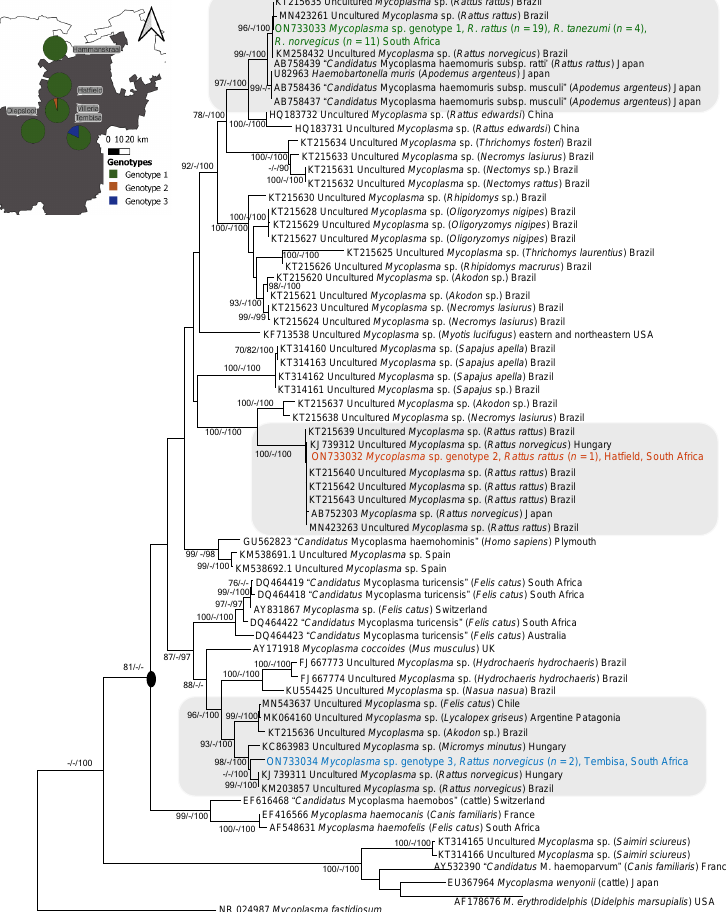
Figure 3. Minimum Evolution tree depicting genetic relationships of the three Rattus -associated hemoplasma genotypes detected in three Rattus species, viz. Rattus rattus , R. norvegicus, and R. tanezumi , sampled across the Gauteng Province of South Africa, with relevant reference sequences. Genbank accession numbers of the three haemoplasmas detected in the current study are indicated. –Genotype 1, which formed a well-supported clade with M. haemomuris , is indicated in green, Geno- type 2 is indicated in orange and Genotype 3 is indicated in blue. The three haemoplasma genotypes detected in this study fell within the Haemofelis cluster (circled at the node) and formed three, separate well-supported clades with haemoplasmas strains previously detected in Rattus species (highlighted in grey). The tree was inferred using the aligned 1063 nucleotide data set of the 16S rRNA gene region. Bootstrap support values ≥ 70% from the minimum evolution analysis (ME; 10,000 bootstrap replicates), maximum likelihood (ML; 10,000 bootstrap replicates); posterior proba- bility support values ≥ 90% from the Bayesian inference (BI; 1,000,000 generations sampled every 10 generations with a 25% burn-in) are indicated as ME/ML/BI next to each node. Genotype 1 also formed a well-supported sister clade to the subspecies “ Candida- tus Mycoplasma subsp. musculi” (sequence identity of 99.4% to U82963; AB758436 and AB75837), previously detected in Apodemus argenteus in Japan. Phylogenetic analyses and nucleotide BlastN searches showed that Genotype 2 formed a well-supported cluster with novel haemoplasma sequences previously detected in Rattus species from Brazil (100% sequence identity to MN423263, KT215643, KT215640 and KT215642) and was closely related to strains from Hungary (99.8% sequence identity to a haemoplasma detected in R. norvegicus , KJ739312) and Japan (99.5% sequence identity to a haemoplasma detected in R. norvegicus , AB752303) (Figure 3). Genotype 3 formed a well-supported cluster